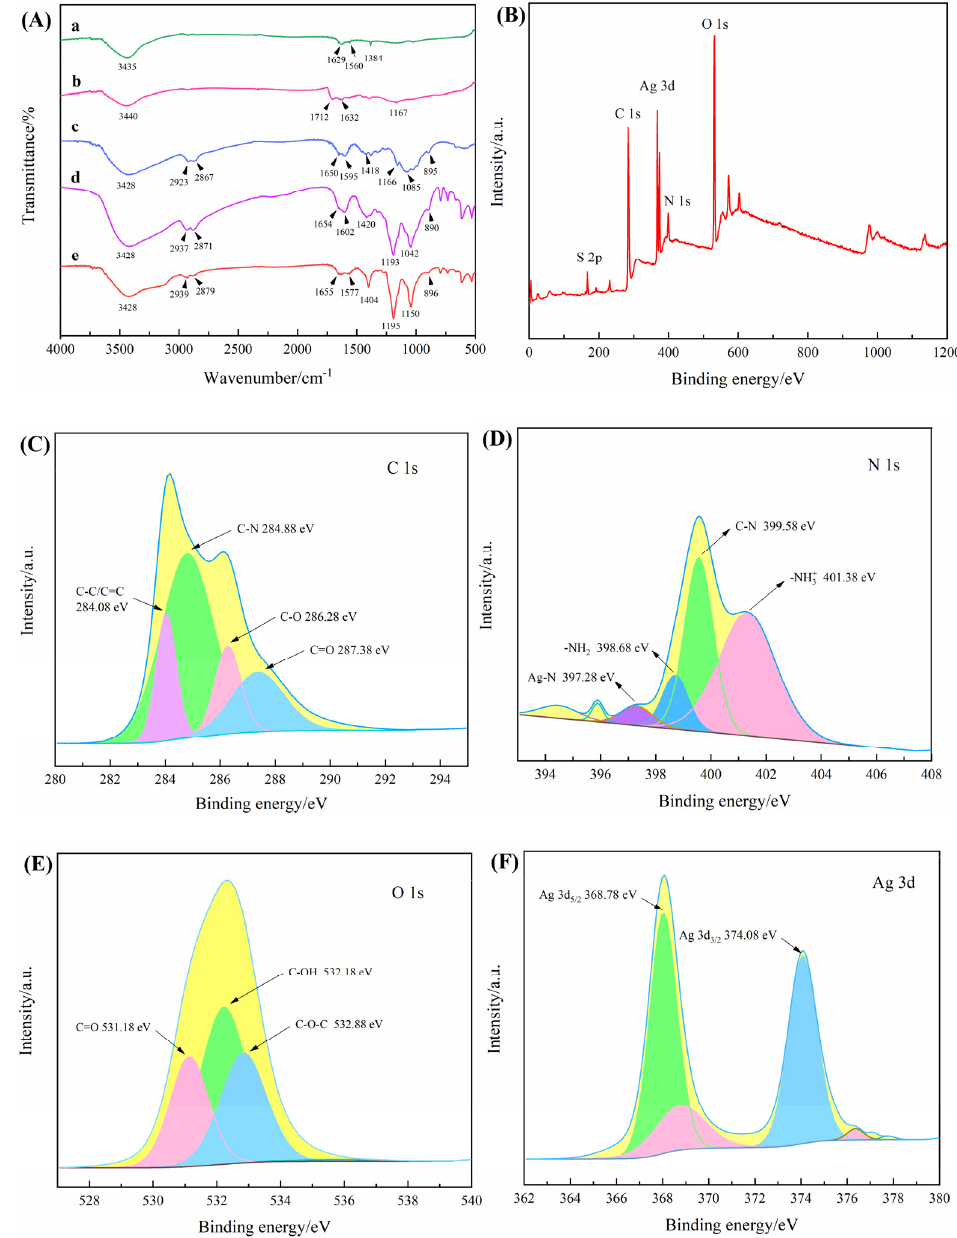
Figure 2. ( A ) FT-IR spectra of MWCNTs (a), PAA-MWCNTs (b), CS (c), SCS (d), and PAA-MWCNTs-Ag-SCS (e); ( B ) XPS survey spectrum of PAA-MWCNTs-Ag-SCS; XPS C 1s ( C ), N 1s ( D ), O 1s ( E ), and Ag 3d ( F ) spectra for PAA-MWCNTs-Ag-SCS. Compared with the curve of CS, curve d exhibited evident absorption peaks at 1042 cm − 1 and 1193 cm − 1 corresponding to the stretching vibration peak of S=O. The absorption peak at 1654 cm − 1 was ascribed to the C=O stretching vibration of the amide group, and the peak at 1602 cm − 1 was attributed to the bending vibration of the SCS branch [28]. All